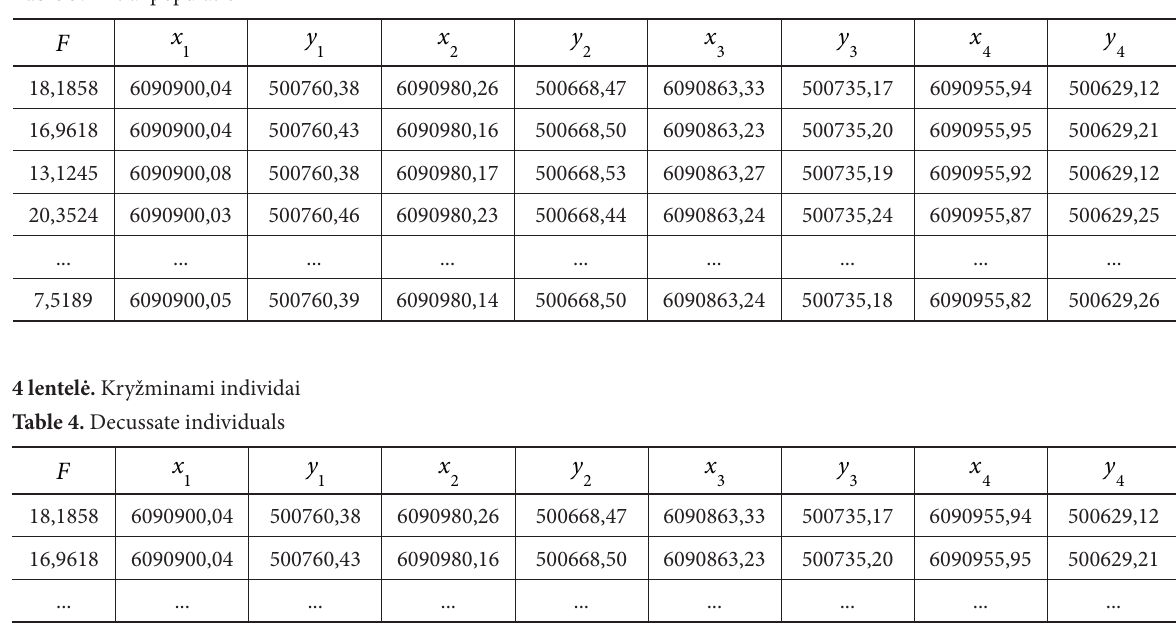
Table 3. Initial population